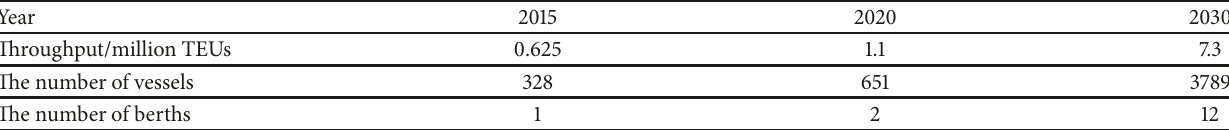
Table 1: The throughput and the number of vessels for three representative years.